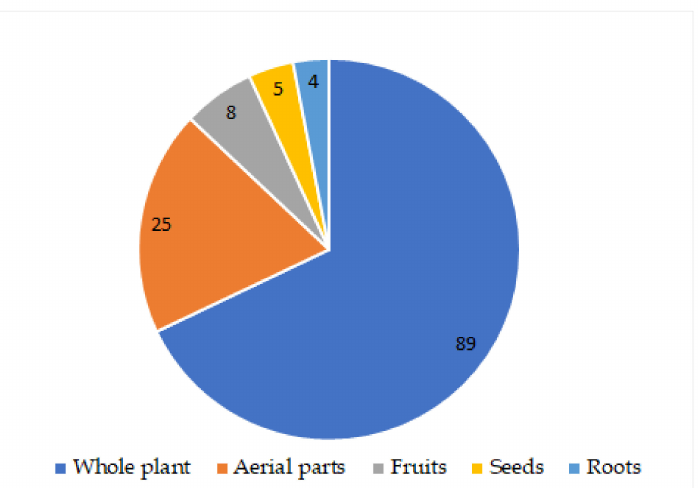
Figure 1. Number of metabolites reported from different parts of C. abrotanoides . 89 Compounds from whole plant; 25 compounds from aerial parts; 8 compounds from fruits; 5 compounds from seeds; 4 compounds from roots.